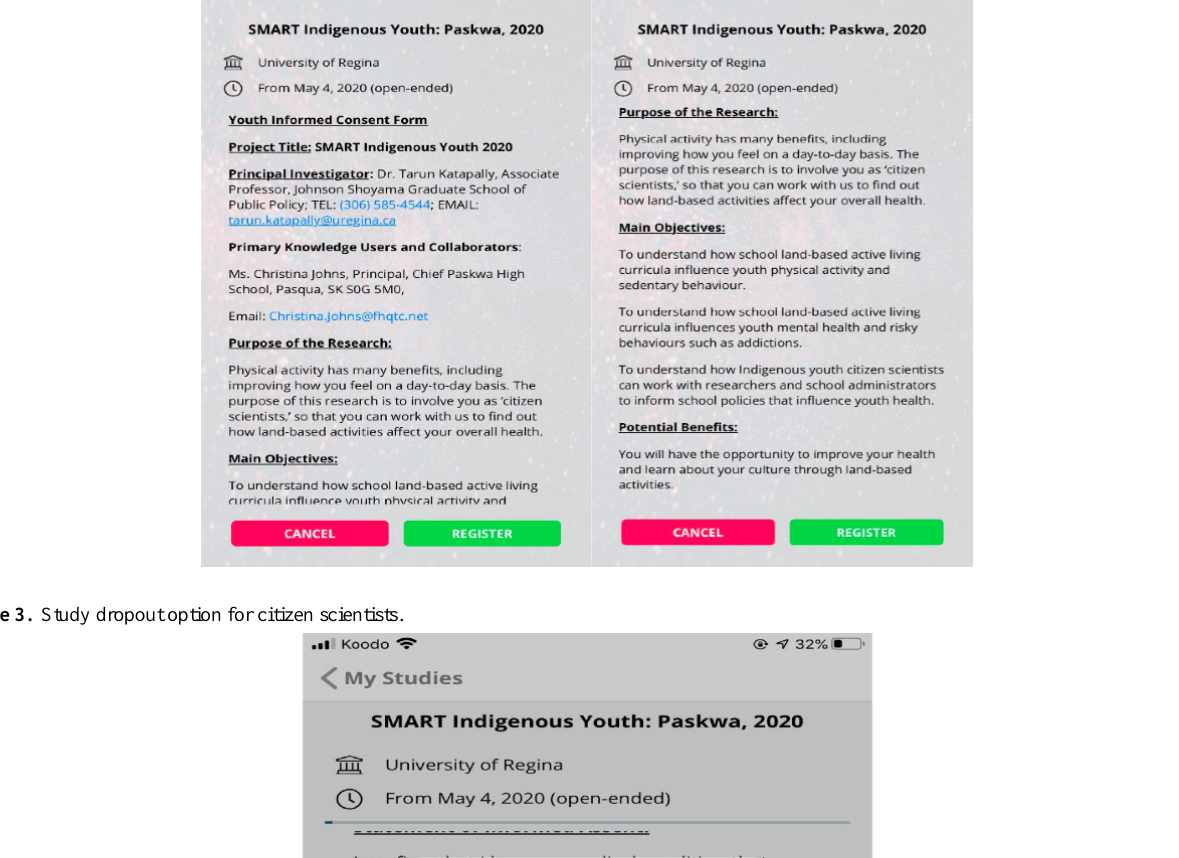
Figure 2. Citizen scientist informed consent via the smartphone app.